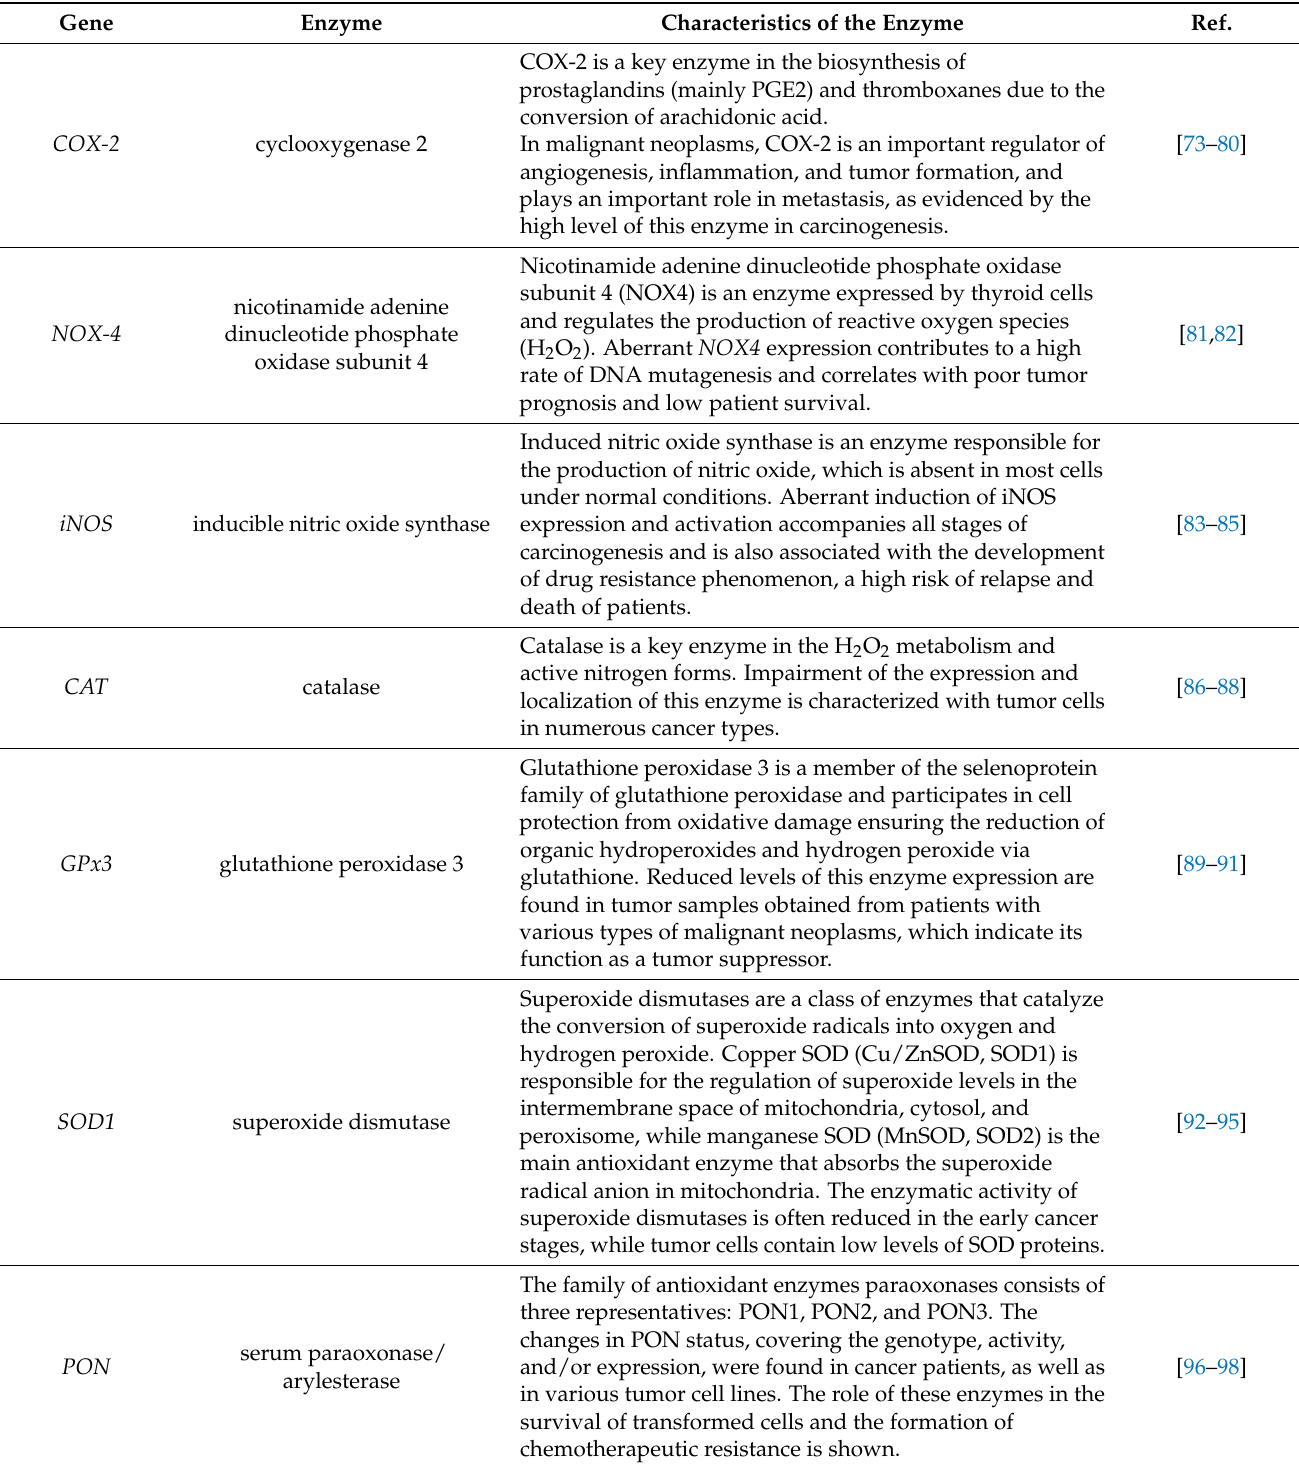
Table 1. Possible biomarkers associated with oxidative stress and the development of cancer pathology. Gene Enzyme Characteristics of the Enzyme Ref.